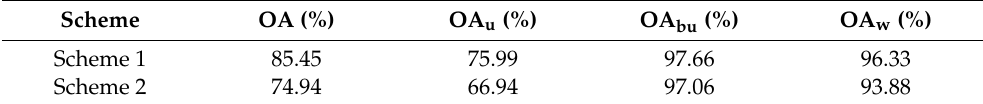
Table 1. The average accuracy of four indicators under the two